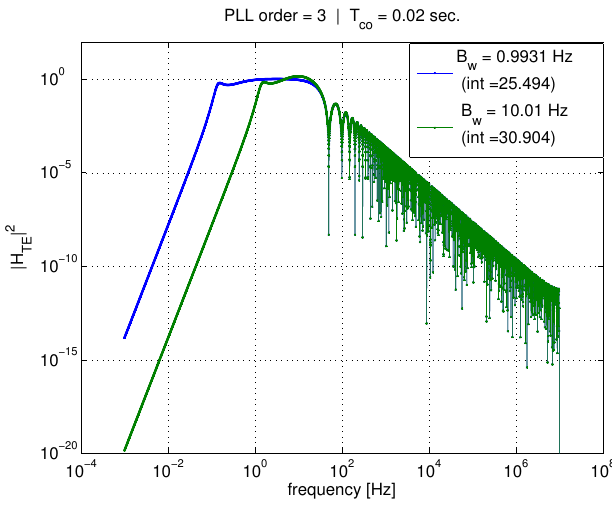
Figure 7. Effect of T co and PLL bandwidth on tracking error transfer function, 20